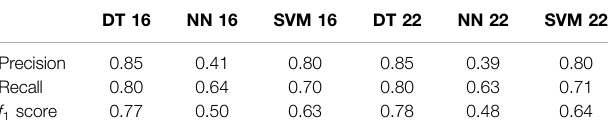
TABLE 5 | The detection of data reduced by LSTM